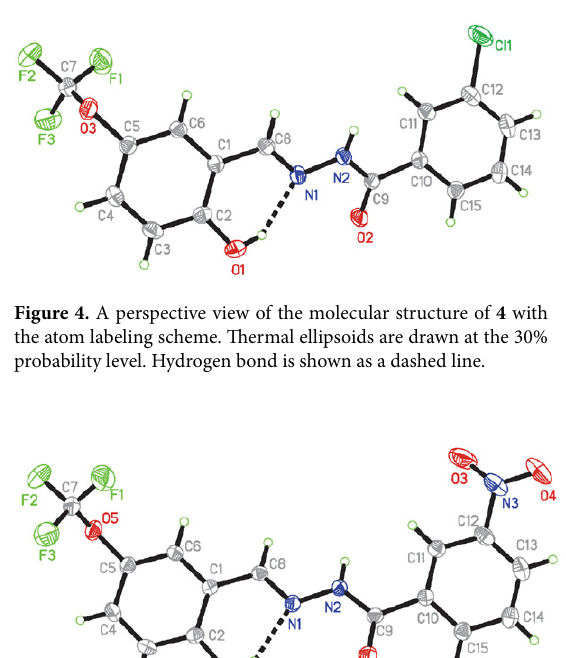
Figure 2. A perspective view of the molecular structure of 2 with the atom labeling scheme. Thermal ellipsoids are drawn at the 30% probability level. Hydrogen bond is shown as a dashed line.